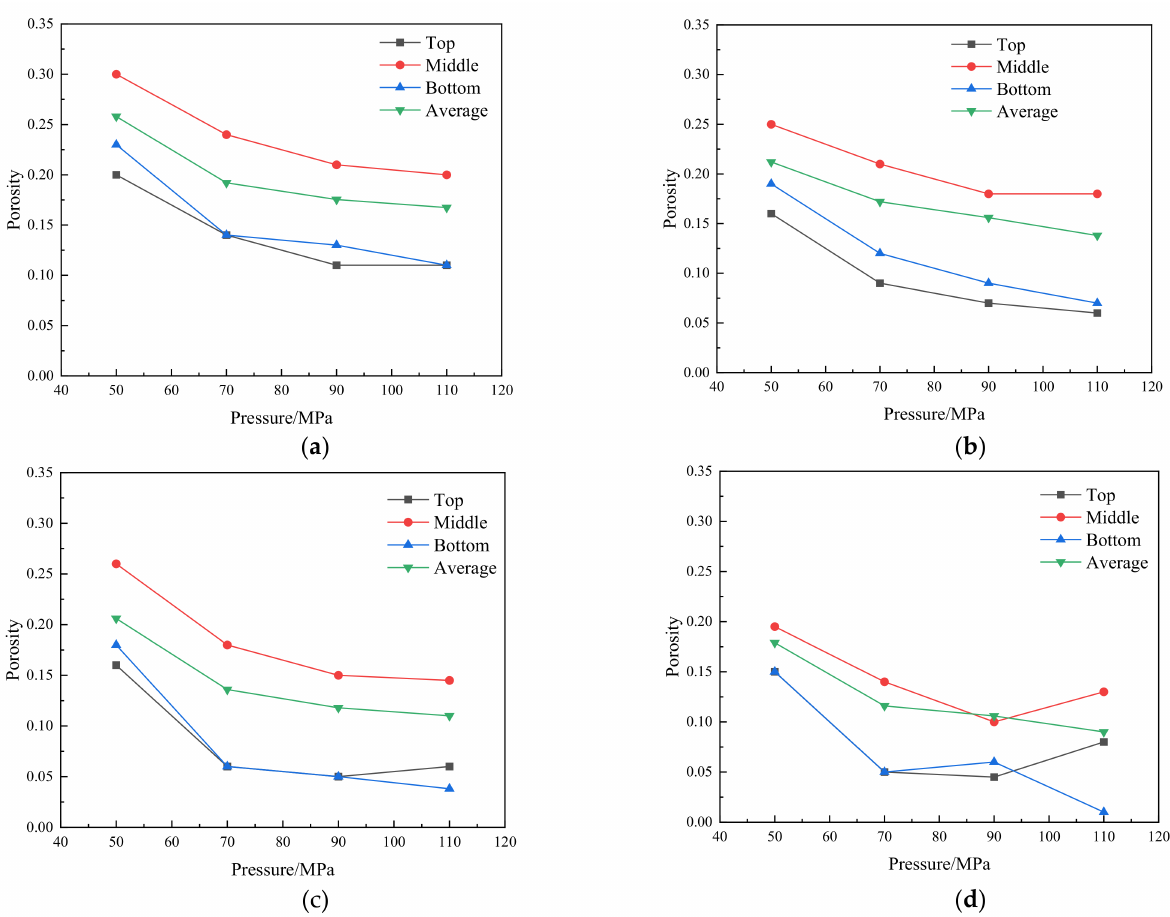
Figure 4. Effect of sintering pressure on porosity under various sintering temperatures: ( a ) 950 ◦ C; ( b ) 1050 ◦ C; ( c ) 1150 ◦ C; ( d ) 1250 ◦